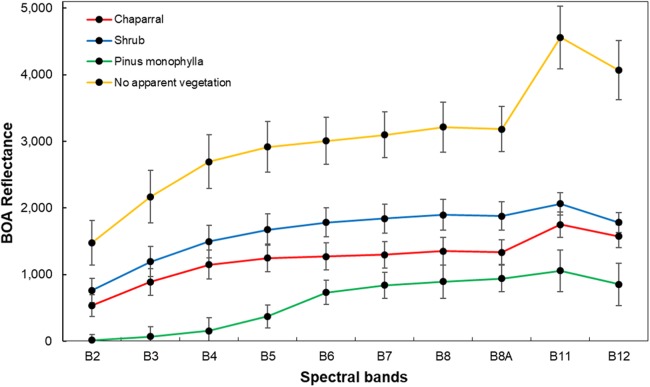
Average spectral signatures of cover vegetation in Sierra La Asamblea, Baja California.